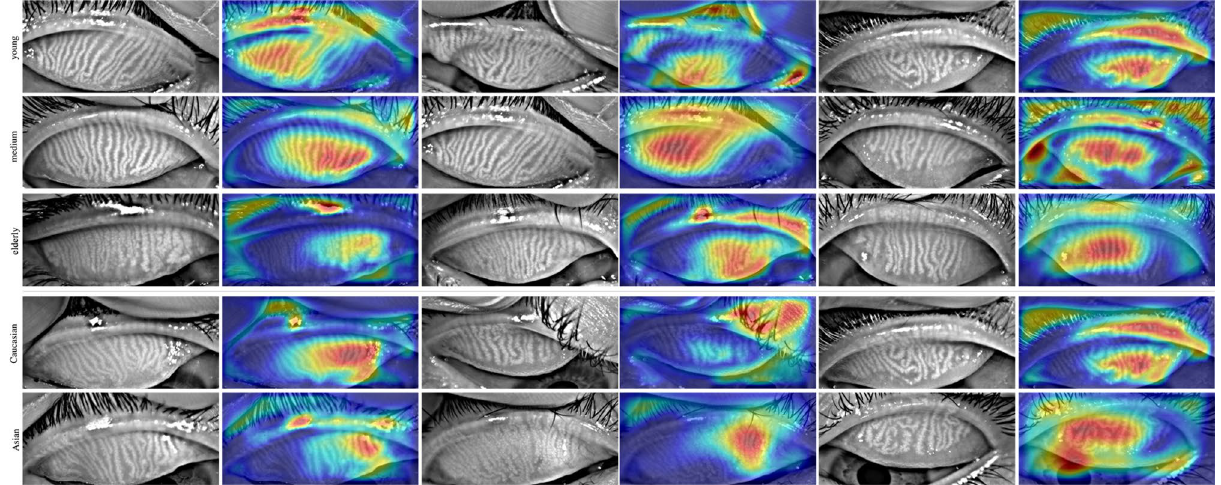
Figure 7. Grad-CAM was applied to the demographic prediction model to visually understand the important regions of the meibography images that contributed to the final classification. The most important visual regions strongly trended towards the glandular image